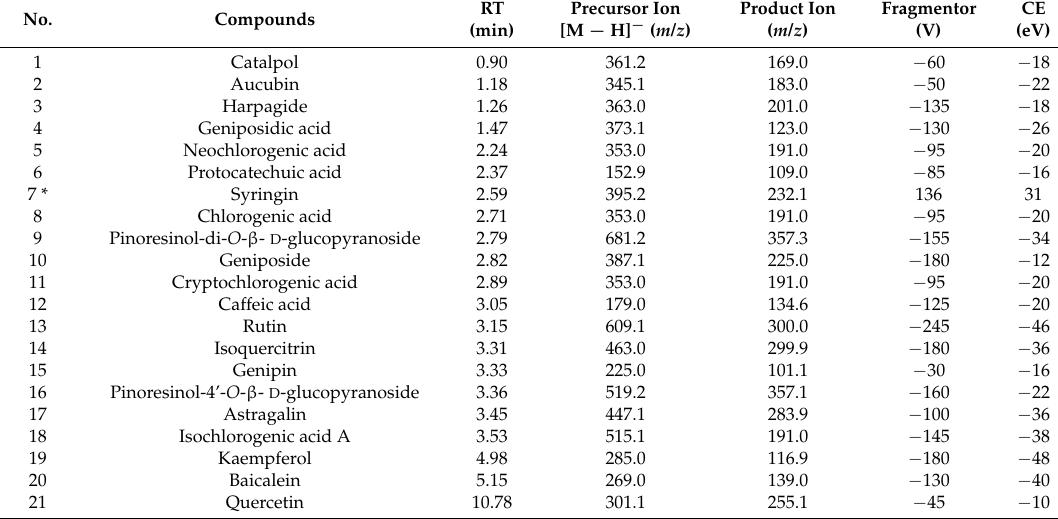
Table 1. Retention time, and related MS data of the target